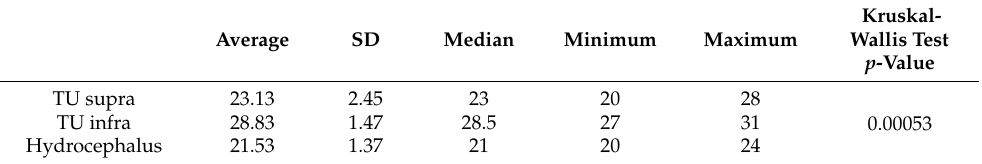
Table 7. Comparison of ICP values according to the primary diagnosis.